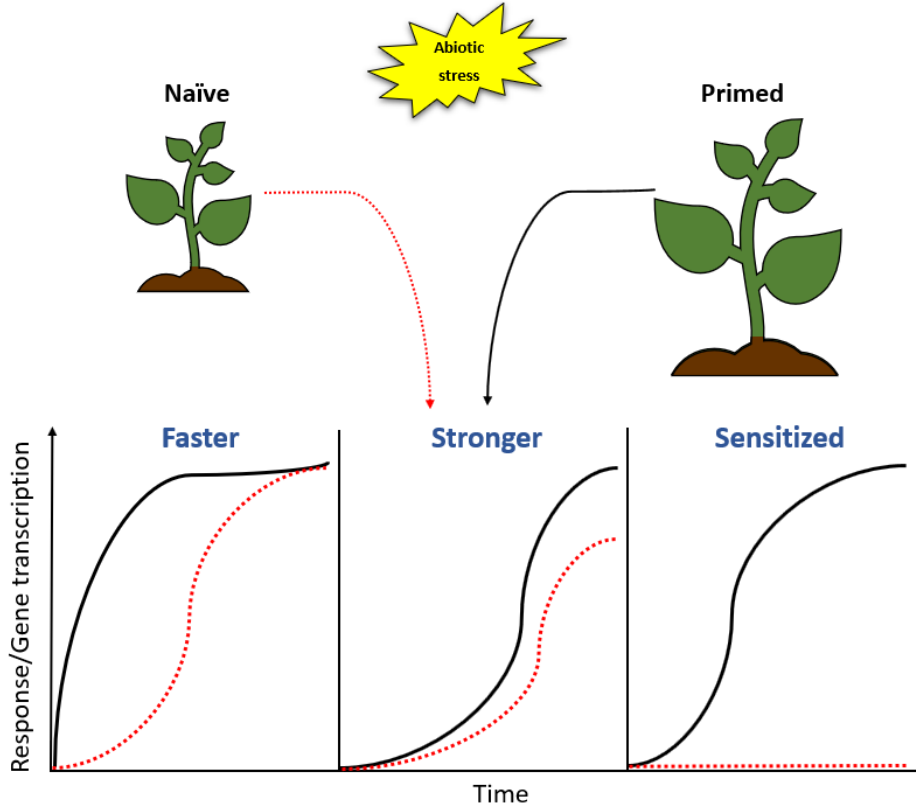
Figure 4. Priming modifies responses upon stress encounter. A naïve plant may be primed by either exposure to stress or other priming factors such as microbes. Response patterns differ in primed and naïve plants; the primed plant may respond to inducing stress more rapidly or more robustly than a naïve plant. It may also be sensitised so that the response is triggered at a lower fitness cost. The primed plant may further modify its response mechanisms to regulate a network of genes that is different from that found in a naïve plant.